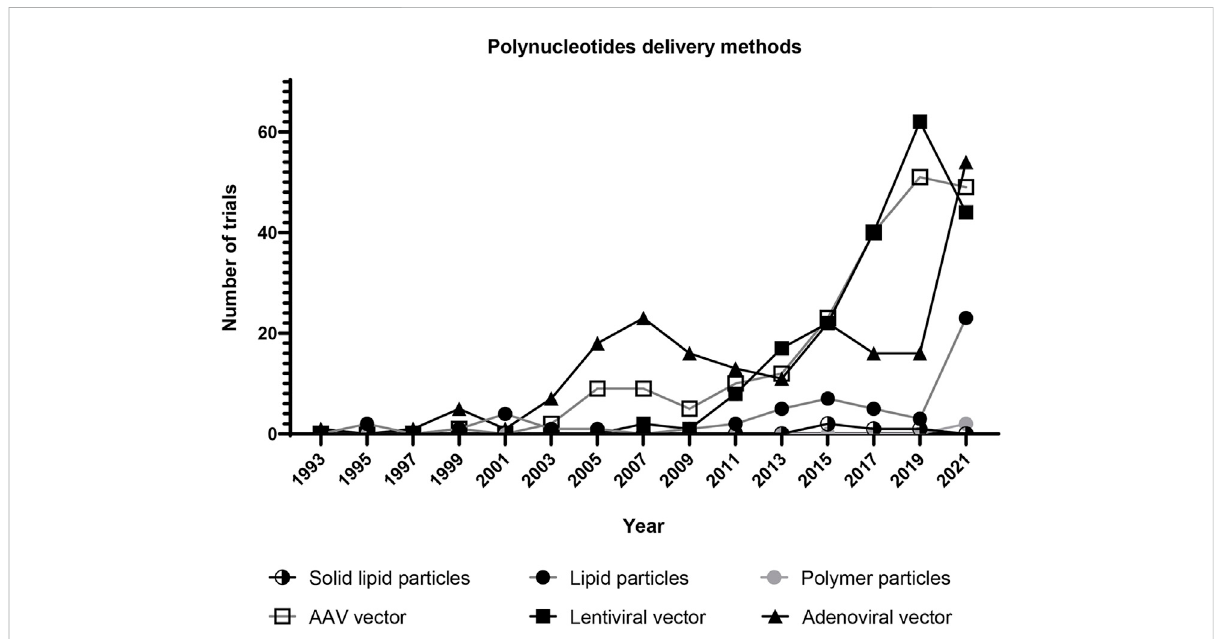
FIGURE 5 Clinicaltrialsofgenetherapyusingselectedvehiclesforpolynucleotidedelivery.Eachdotrepresentsthenumberofclinicaltrialsin2 years.The trials using lentiviral, adenoviral, and AAV vectors have grown since 1995. The trials using lipid nanoparticles have signi fi cantly increased since 2019. Thisisprobablydue tothedevelopmentofCOVID-19vaccines.(Solidlipidparticledatawerecollectedbysearchingfor “ solidlipidnanoparticle ” and “ nanostructured lipid carrier ” in the Other terms search fi eld on ClinicalTrials.gov. Lipid particle data were collected by searching for “ liposome gene ” and “ lipid nanoparticle ” in the Other terms search fi eld. Polymer particle data were collected by searching for “ polymer nanoparticle ” and “ dendrimer ” in the Other terms search fi eld. Lentiviral vector data were collected by searching for “ lentiviral vector ” in the Other terms search fi eld. Adenoviral vector data were collected by searching for “ adenoviral vector ” in the Other terms search fi eld. AAV vector data were collected by searching for “ AAV vector ” in the Other terms search fi eld. All data was collected from ClinicalTrials.gov on 22 April